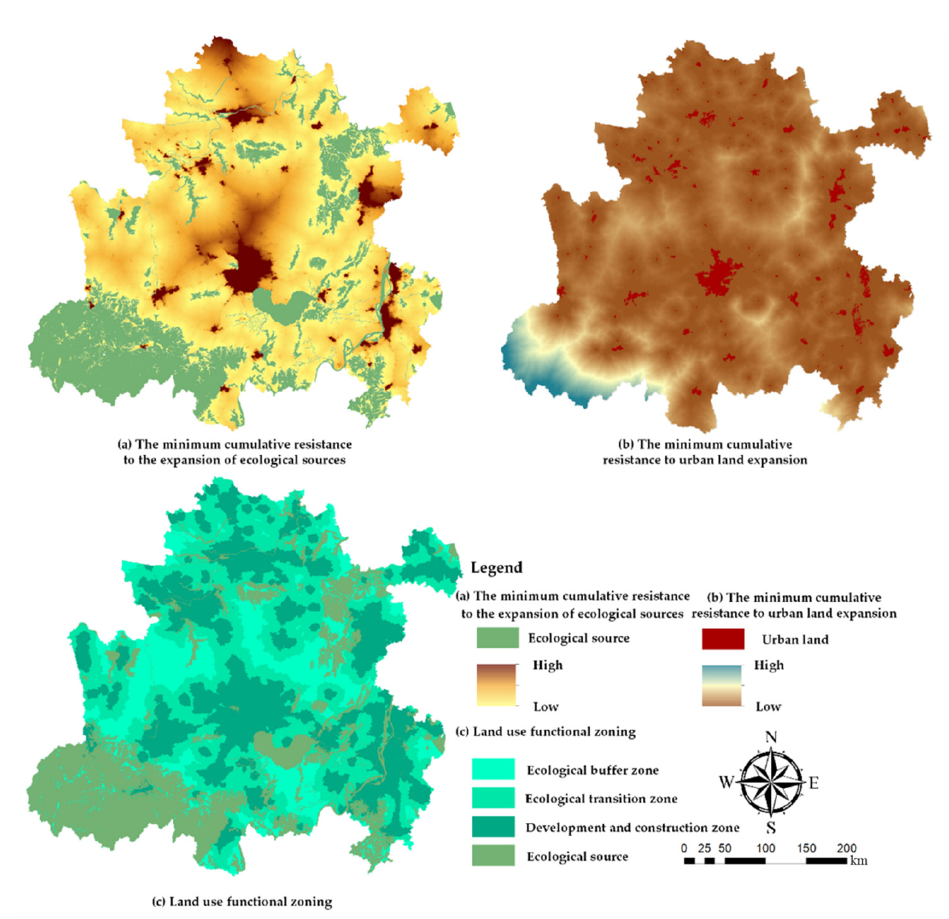
Figure 6. Minimum cumulative resistance surface and land function zoning map.